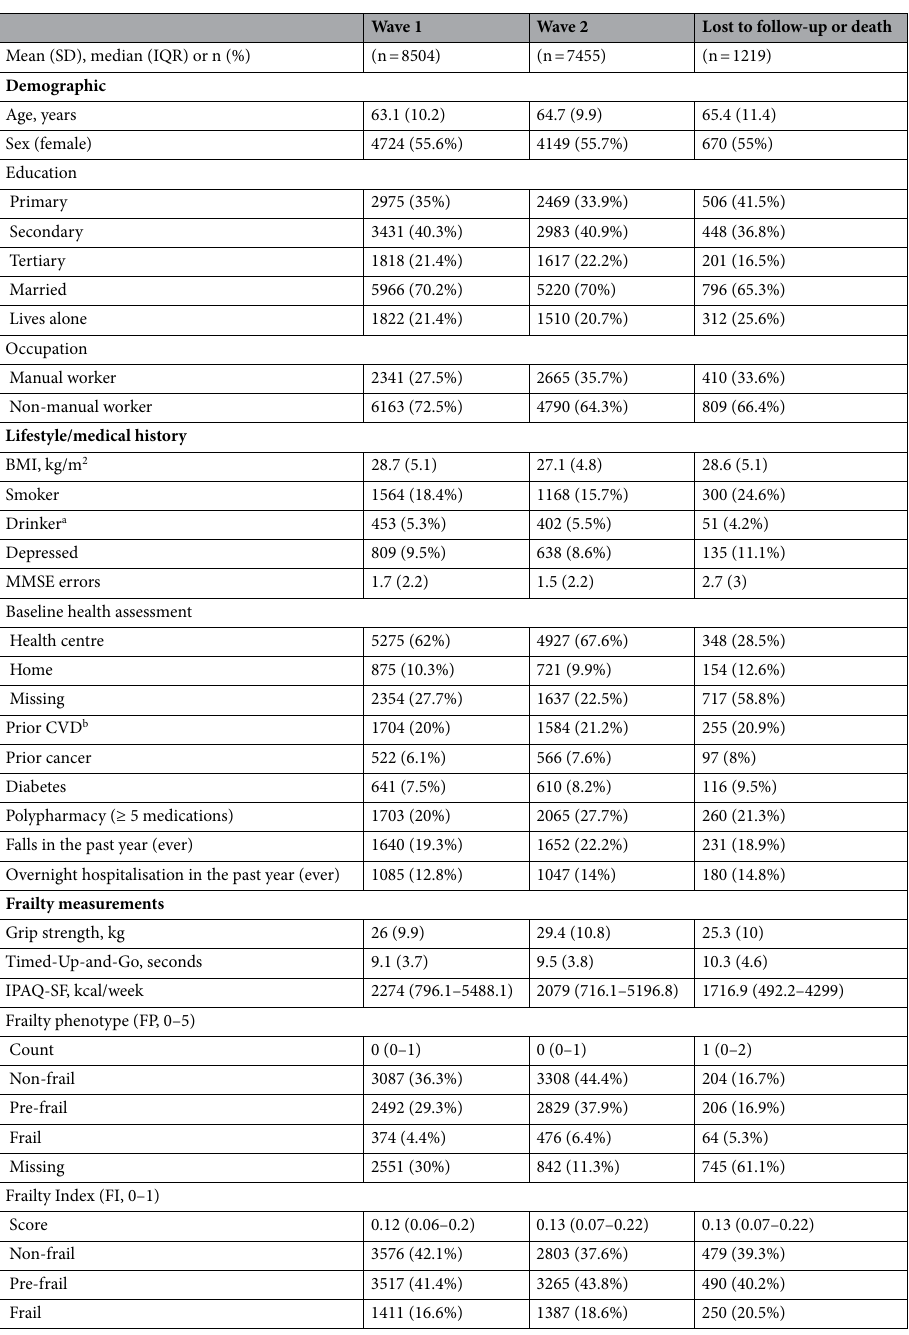
Table 1. Selected characteristics of study participants at Waves 1 and 2. Continuous data presented as mean (SD) for age, BMI, grip strength and TUG, or median (IQR) for MMSE errors, frailty scores/count and IPAQkcal. Baseline data reported for lives alone, education level, and prior CVD for all groups due to data availability. a Drinkers consuming levels above the weekly limit on standard drinks (1/2 pint of beer or a glass of wine) according to the government guidelines (> 21 for men; > 14 for women). b CVD defined as any of the following present: angina, heart attack, diabetes, stroke, transient ischaemic attack, or heart murmur. BMI body mass index, CVD cardiovascular diseases, FI frailty index, FP frailty phenotype, MMSE Mini-Mental State Examination, IPAQ‑SF International Physical Activity Questionnaire-Short